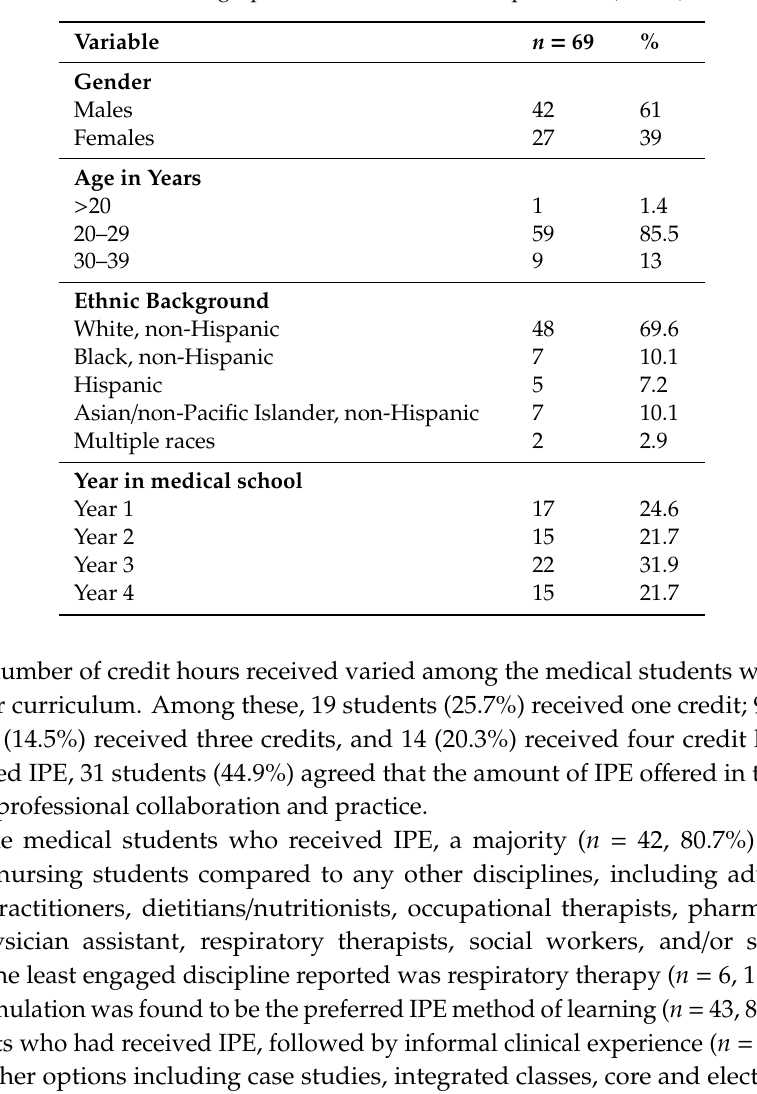
Table 1. Demographic Characteristics of Respondents ( n =